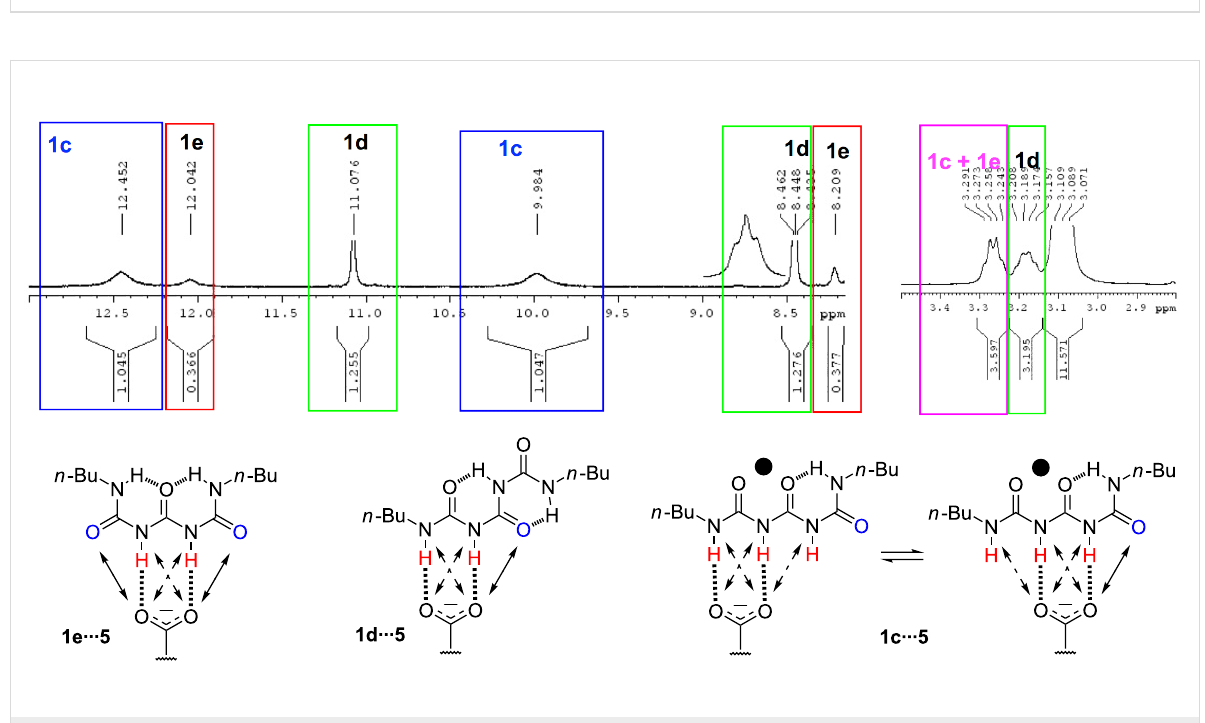
Figure 7: The signal labelling for [ 1 ]:[ 5 ] in 1:1 ratio exemplified on the spectra recorded at − 40 °C (CDCl 3 ) and structure of complexes.